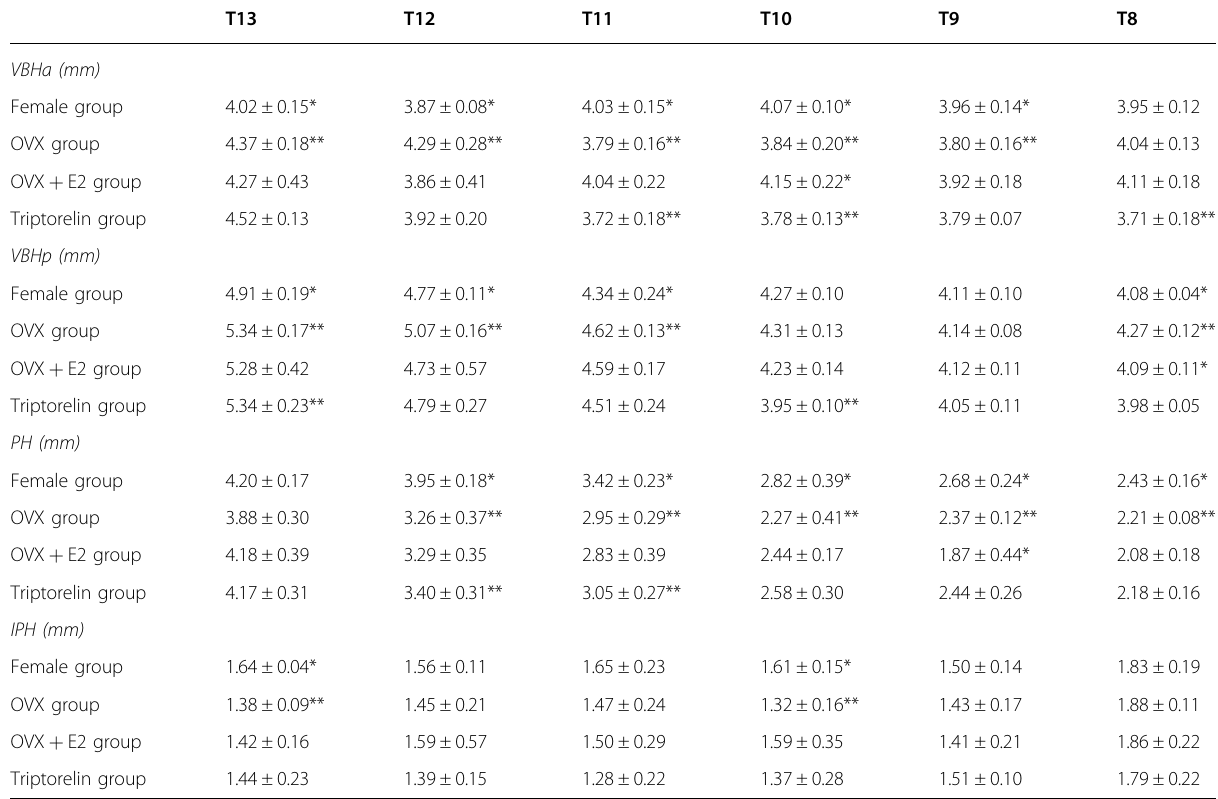
Table 2 Detailed sagittal measurements of the thoracic vertebrae (T8 – T13) in the four groups